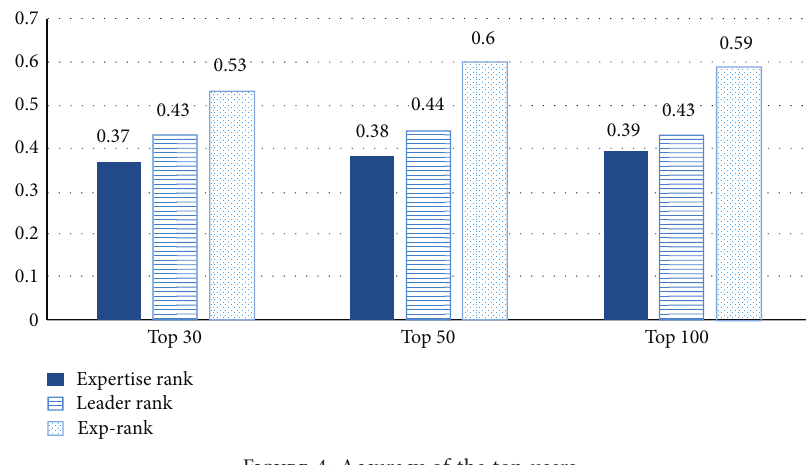
Figure 4: Accuracy of the top users.